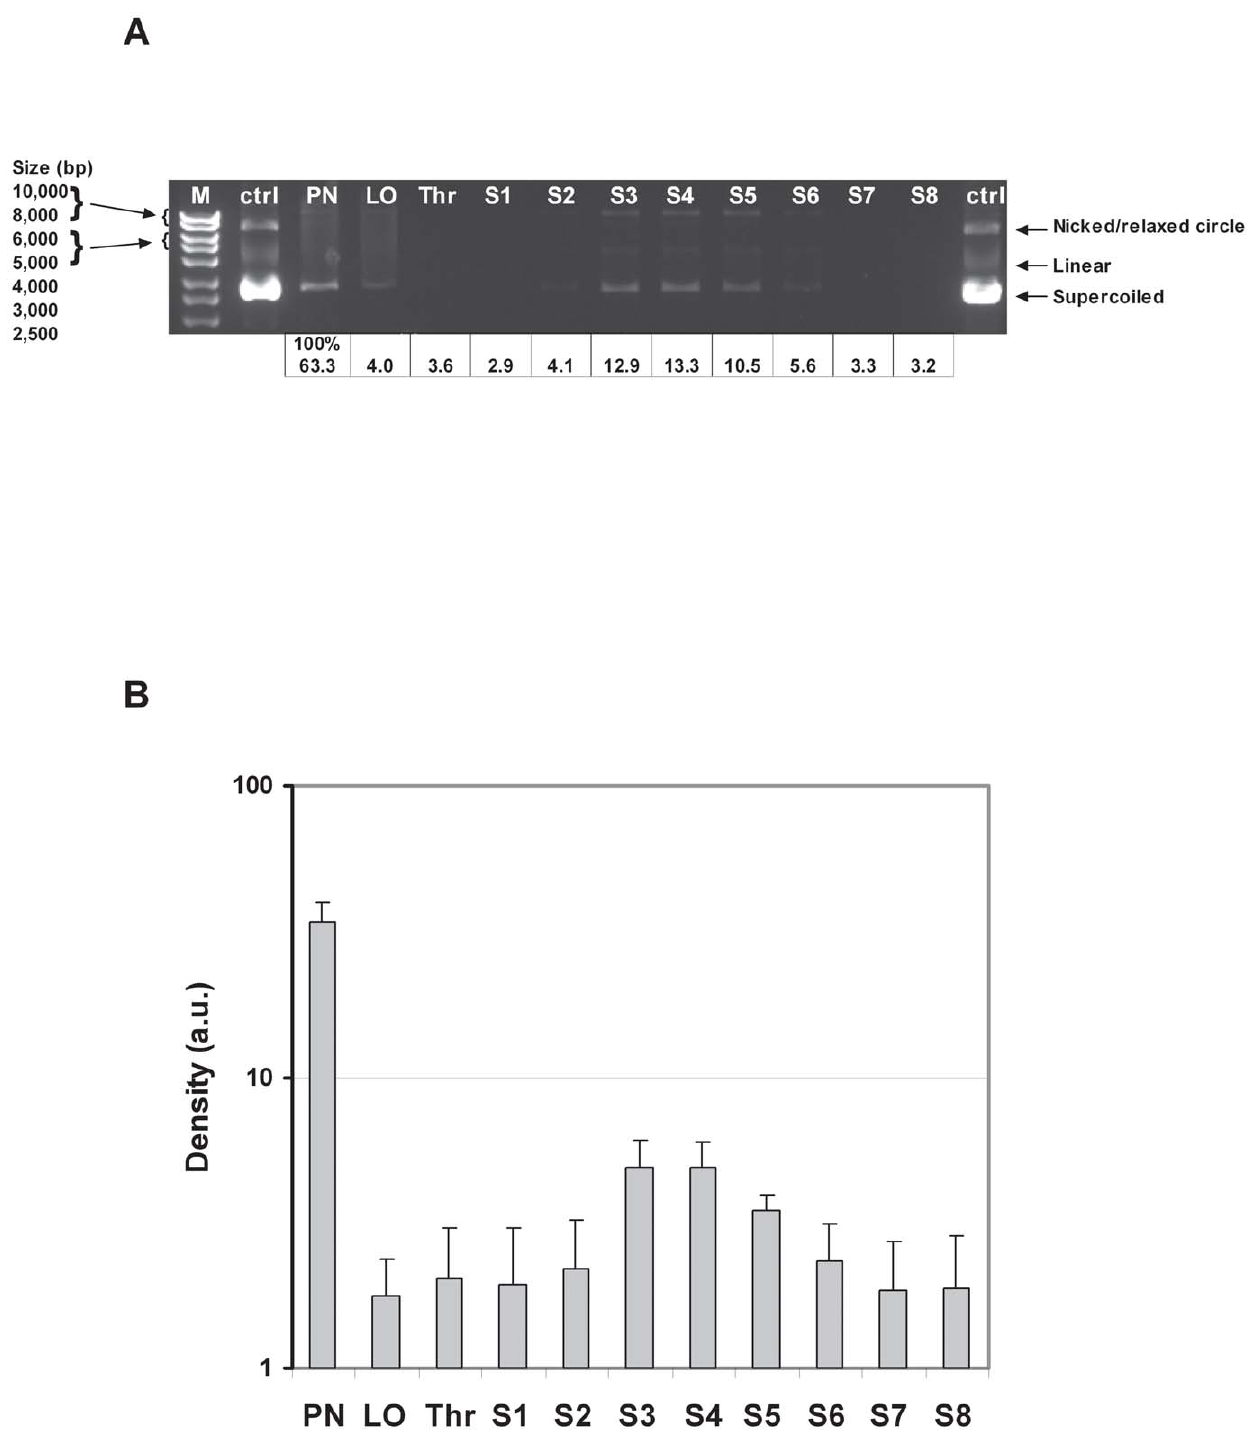
Figure 2. Analysis of the DNA recovered from nanocomplexes collected from the NGI stages. A Visualisation of bands on agarose gel: After nebulisation of RTNs through the NGI with the AeroEclipse, the DNA (pEGFP-N1 plasmid) was released from samples collected from each stage, the throat (Thr), as well as the suspension pre-nebulisation (PN) and the leftover (LO) in the nebuliser reservoir. The released DNA was electrophoresed on agarose gel, alongside the original plasmid used to form the complexes (ctrl), and visualised by EtBr staining under UV light. A representative experiment is shown. The total yield of DNA of the experiment shown was 63% and the yield relative to each band of DNA in the gel is also indicated underneath. B Quantification of bands of DNA released from the RTNs: Nanocomplexes prepared at the DNA concentration of 160 m g/ml were nebulised through the NGI and the RTNs pre-nebulisation (PN), the leftover in the nebulisation chamber (LO) or deposited in the throat (Thr) or in the various stages (S1–S8) were collected. The DNA extracted from the samples was analysed by agarose gel electrophoresis. The agarose gel images acquired were analysed by ImageJ. To compare the density values per area, the region of interest (ROI) of each independent experiment was normalised to 1, before calculating themean values. The experiments were performed twice andtheerror bars representthestandarderror of themean.